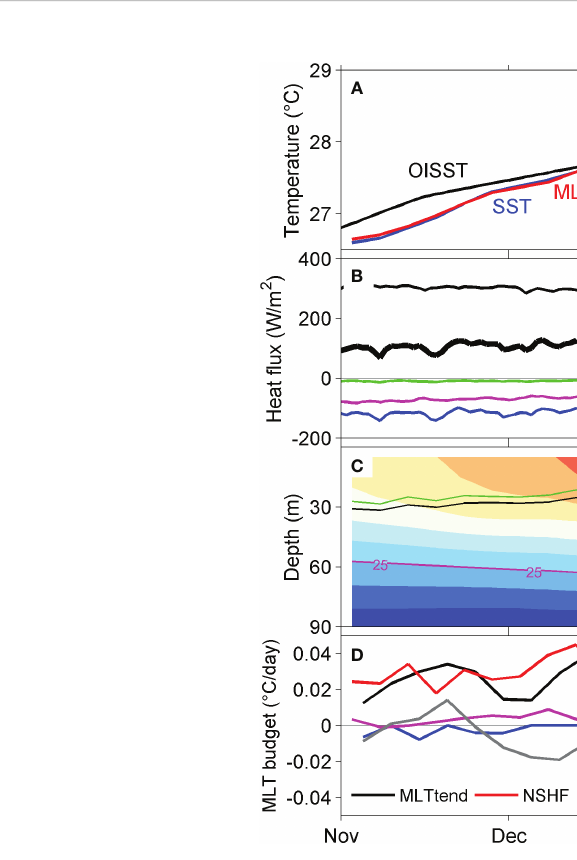
FIGURE 6 Time series of the (A) daily OISST (black line; °C), pentad-averaged SST (blue line; °C), and MLT (red line; °C) from SODA climatology; (B) daily shortwave radiation (thin black line; W m -2 ), longwave radiation (magenta line; W m − 2 ), latent heat fl ux (blue line; W m − 2 ), sensitive heat fl ux (green line; W m − 2 ), and net air – sea heat fl ux (thick black line; W m − 2 ) from TropFlux; (C) upper ocean temperature (°C) and (D) MLT budget components (°C day − 1 ) from November to January. Positive heat fl ux in (B) represents a gain to the ocean. The green and black lines in (C) represent the MLD and ILD,